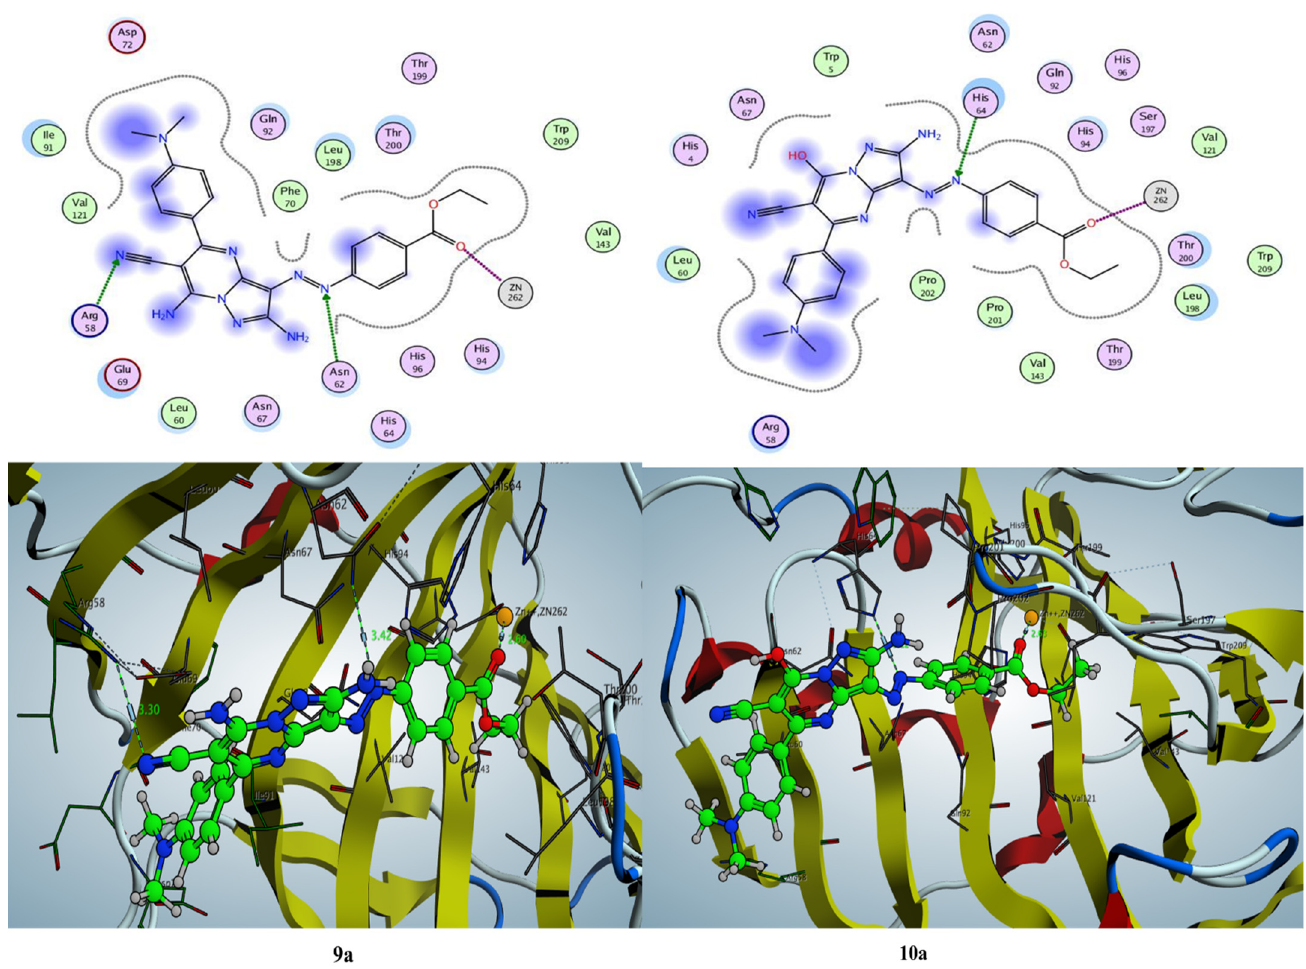
Figure 12. 2D and 3D enzyme–ligand interaction of compounds 9a and 10a inside the active site of h CA-II. h